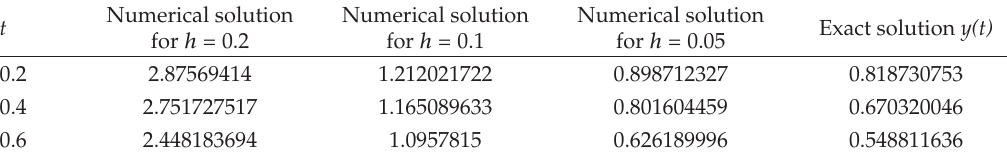
Table 1: Comparison between the numerical solutions for di ff erent h and the exact